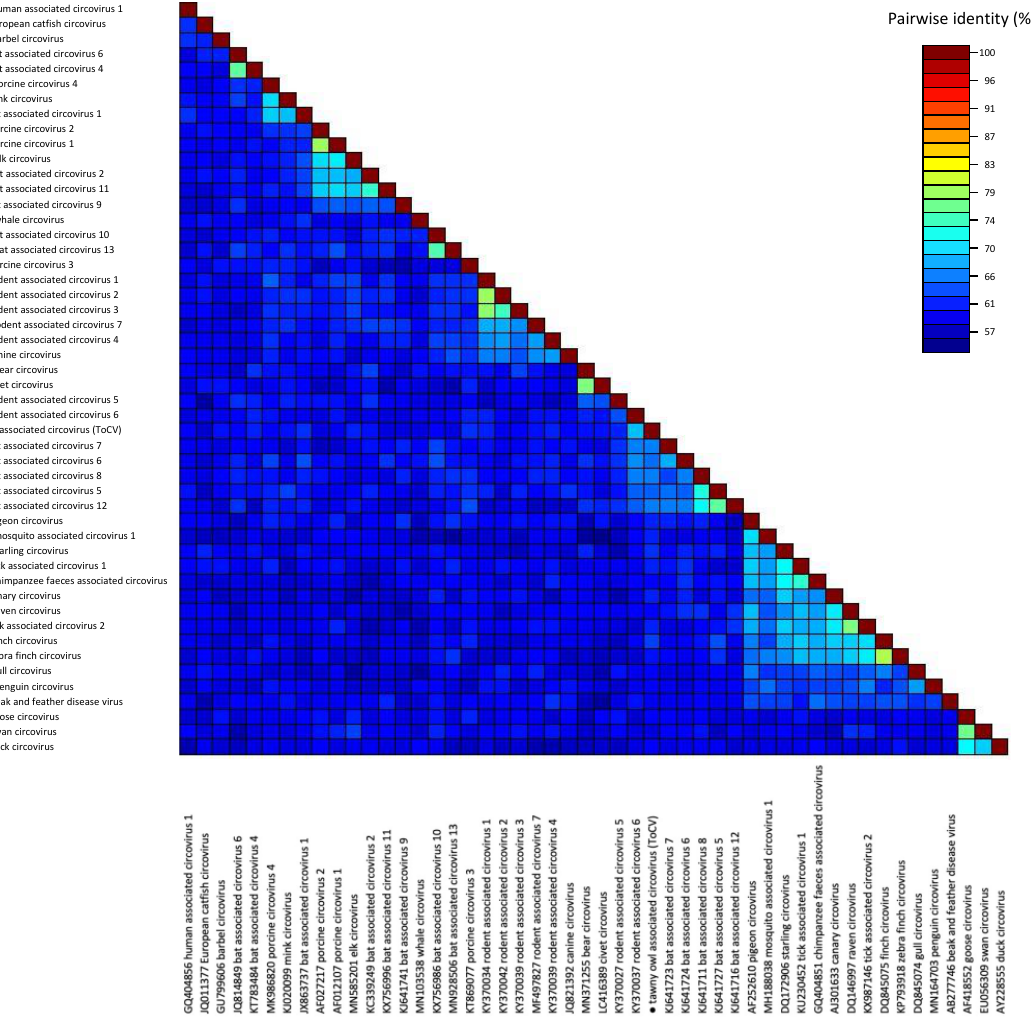
Figure 2. Full genome pairwise identity matrix of representative sequences of every known species of the genus Circovirus . The tawny owl-associated circovirus is marked with a black dot.